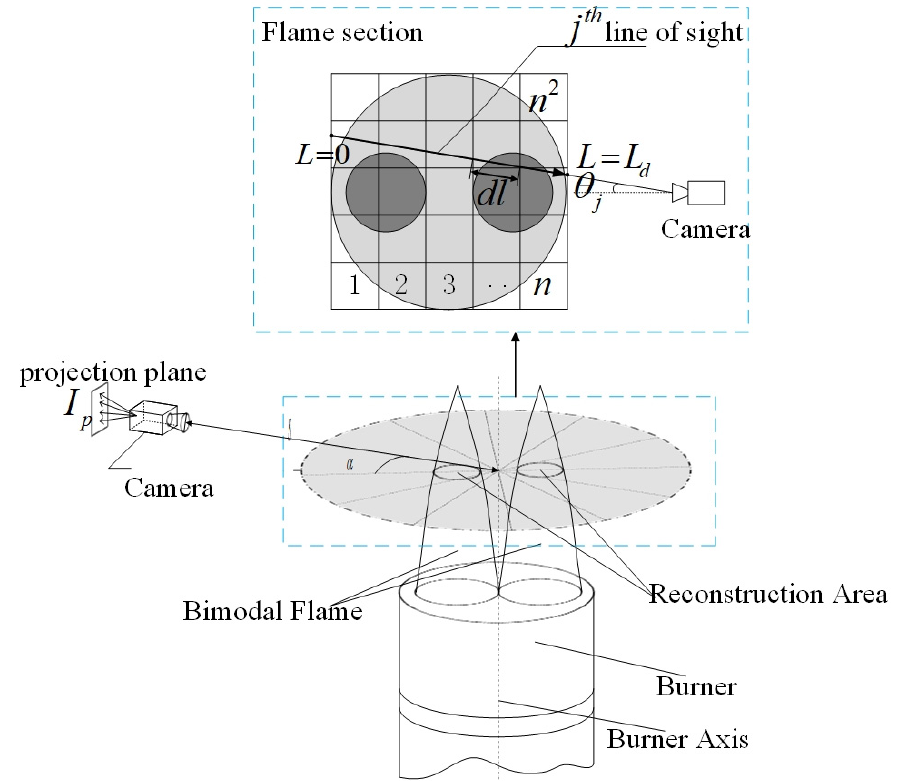
Figure 1. Multi-camera tomographic reconstruction system.